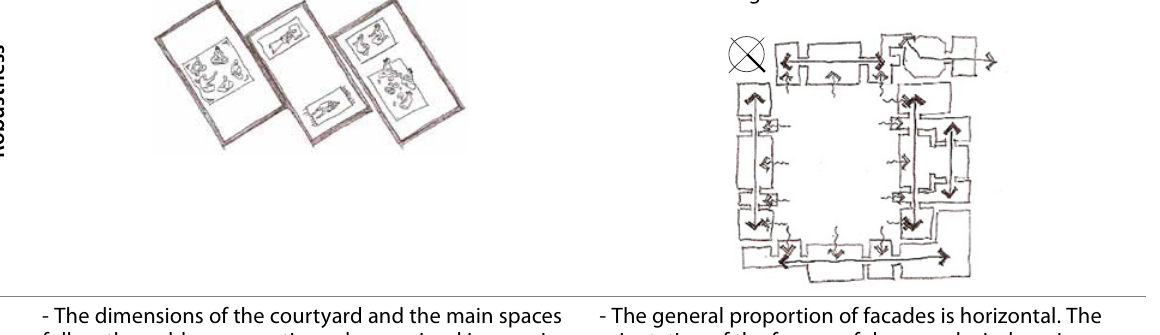
This identifies the main spaces.